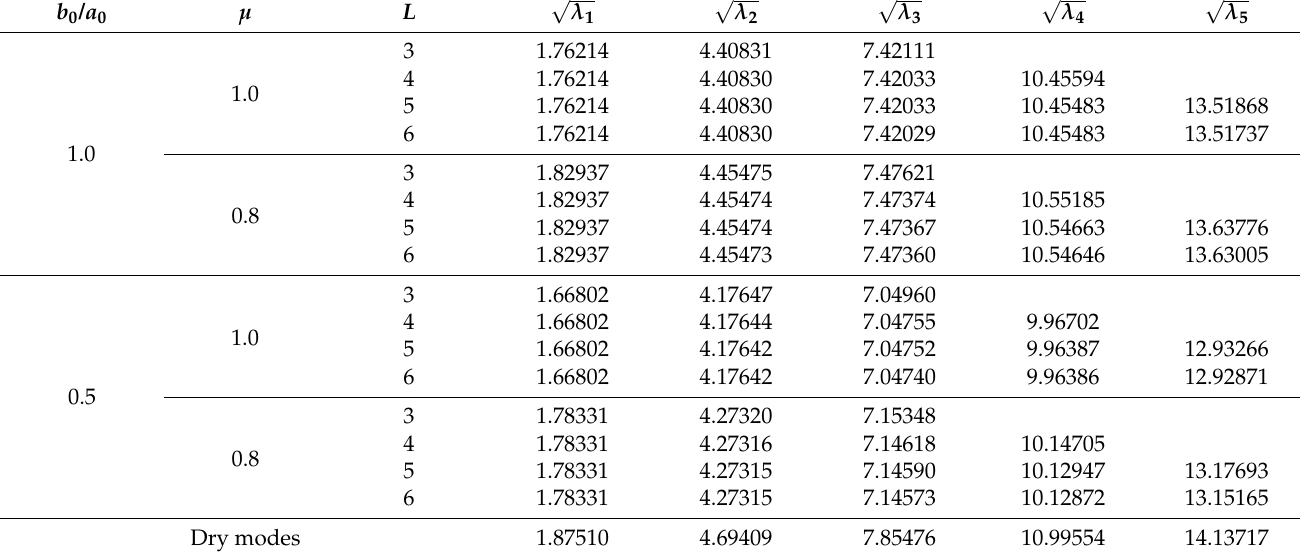
Table 1. The non-dimensional frequency parameters of elliptical cylinders partially submerged in water, using a different number of terms of vibrating beam functions ( N = 20, J =